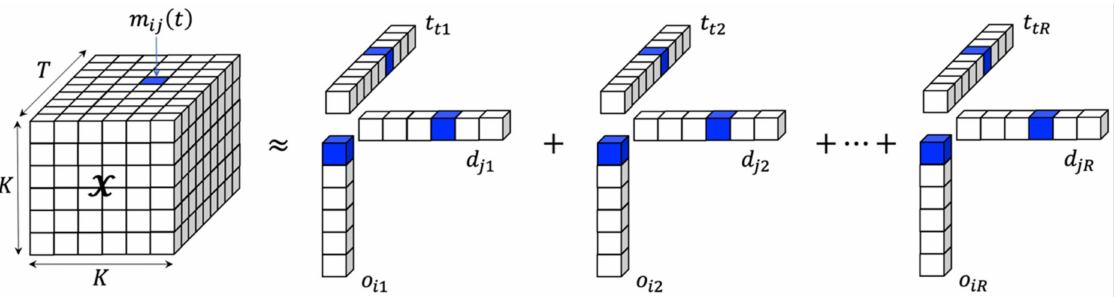
Figure 5. Factorization of the ODT tensor.